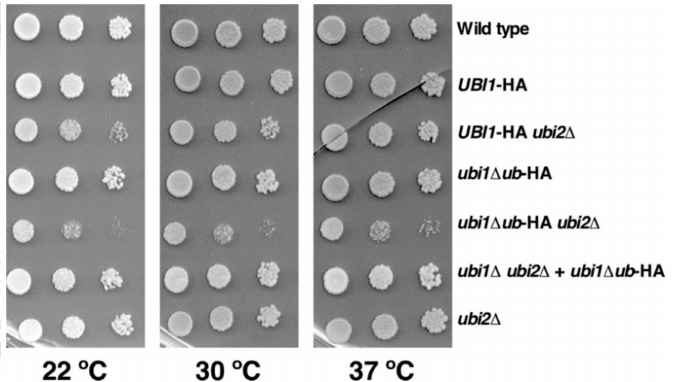
Figure 2. The genomically integrated ubi1 ∆ ub -HA allele confers a slow-growth phenotype. Growth analysis of the indicated strains, either expressing a C-terminally HA-tagged Ubi1 ( UBI1 -HA) or a Ubi1 ∆ ub ( ubi1 ∆ ub -HA) variant protein from the UBI1 genomic locus or from a centromeric plasmid ( + ubi1 ∆ ub -HA) in a wild-type UBI2 or a ubi2 ∆ null mutant background. Strains W303-1A (Wild type), SMY113 ( UBI1 -HA), SMY256 ( UBI1 -HA ubi2 ∆ ), SMY107 ( ubi1 ∆ ub -HA), SMY257 ( ubi1 ∆ ub -HA ubi2 ∆ ), SMY215 [YCplac111-ubi1 ∆ ub-HA] ( ubi1 ∆ ubi2 ∆ + ubi1 ∆ ub -HA), and JDY923 ( ubi2 ∆ ) were spotted in fivefold serial dilution steps onto YPD plates, which were incubated for 4 days at 22 ◦ C or for 3 days at 30 ◦ C and 37 ◦